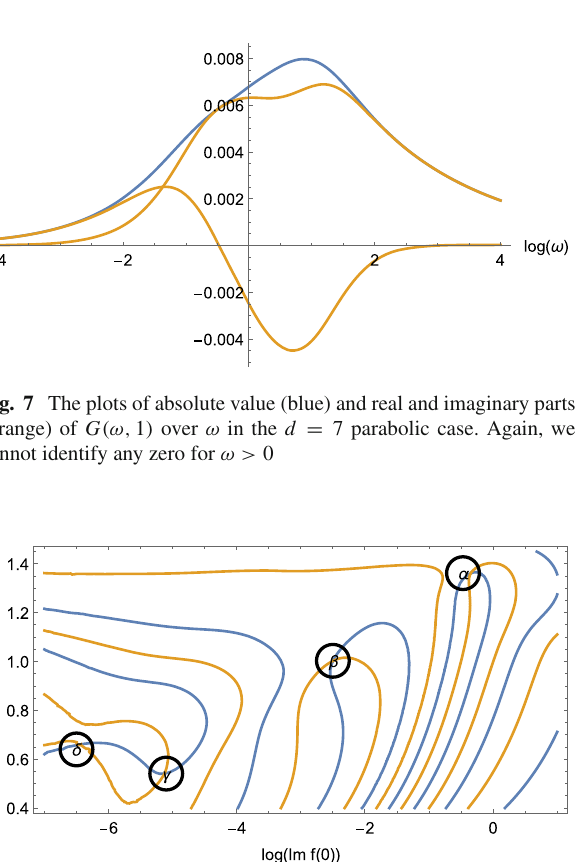
8 Solutions for d = 4 , 5 hyperbolic class Four distinct solutions for four dimensions in the hyperbolic case were explored in [1], in order of decreasing Im f ( 0 ) , as depicted in Fig.